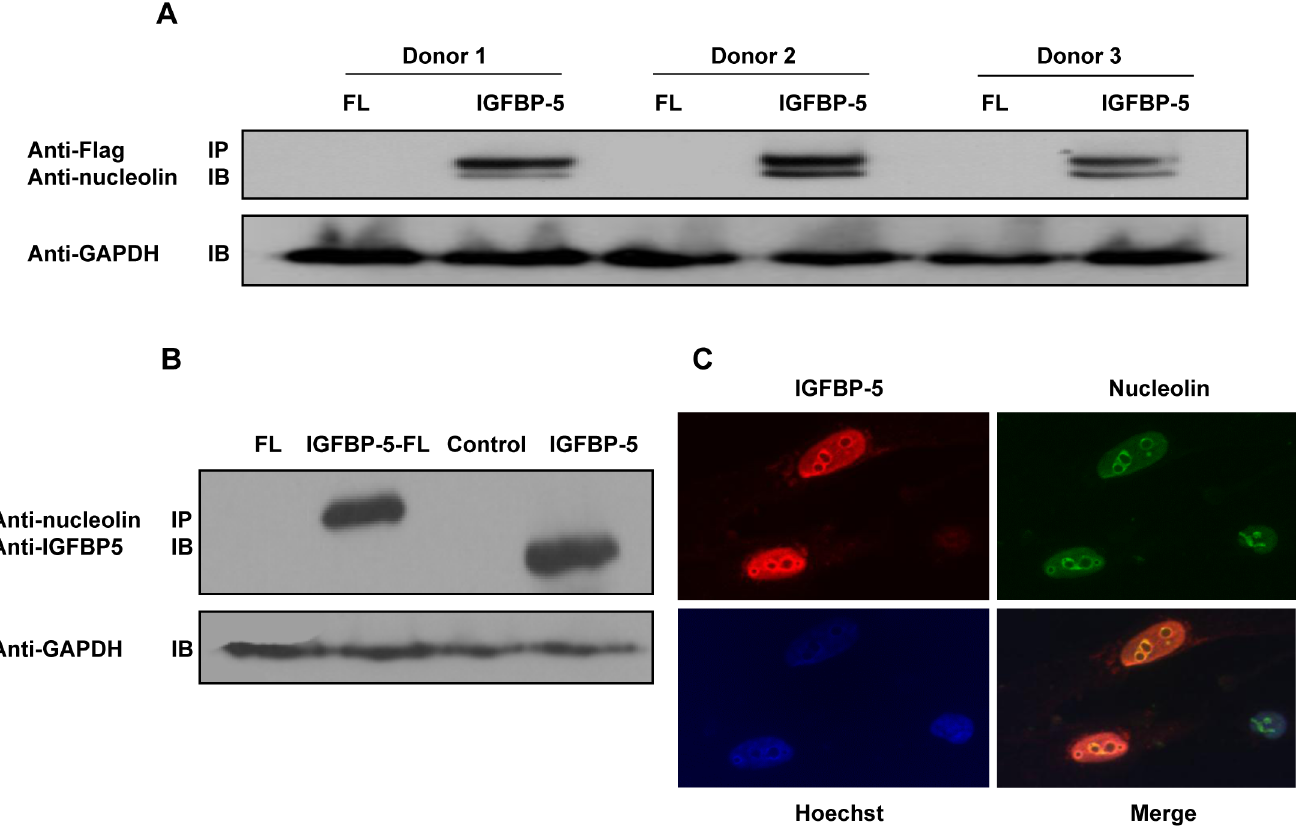
Fig 4. Nucleolin is an IGFBP-5 binding partner. Following identification of nucleolin using mass spectrometry, interaction with IGFBP-5 was confirmed using co-precipitation. (A) Wild type IGFBP-5 binds nucleolin in fibroblasts from three different donors. (B) Reverse pull-down with nucleolin antibody confirms the interaction with IGFBP-5. GAPDH in input lysate was detected to confirm that lysate fractions with equivalent protein levels were used for the IP. (C) Co-localization of nucleolin and IGFBP-5 is detected using immunofluorescence (IGFBP-5: red; nucleolin: green).